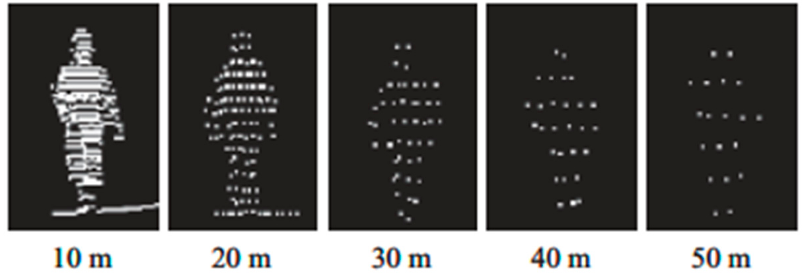
Figure 5. Pedestrian 3D point clouds characteristics at different distances.